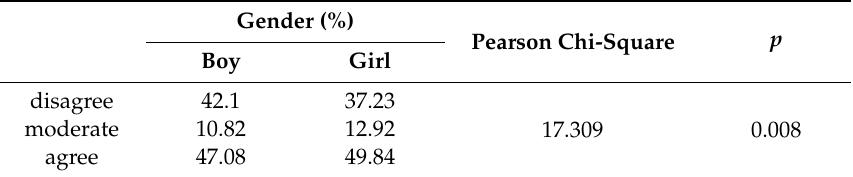
Table 2. The results of children of di ff erent genders using di ff erent painting materials on the reproducing other people’s paintings.